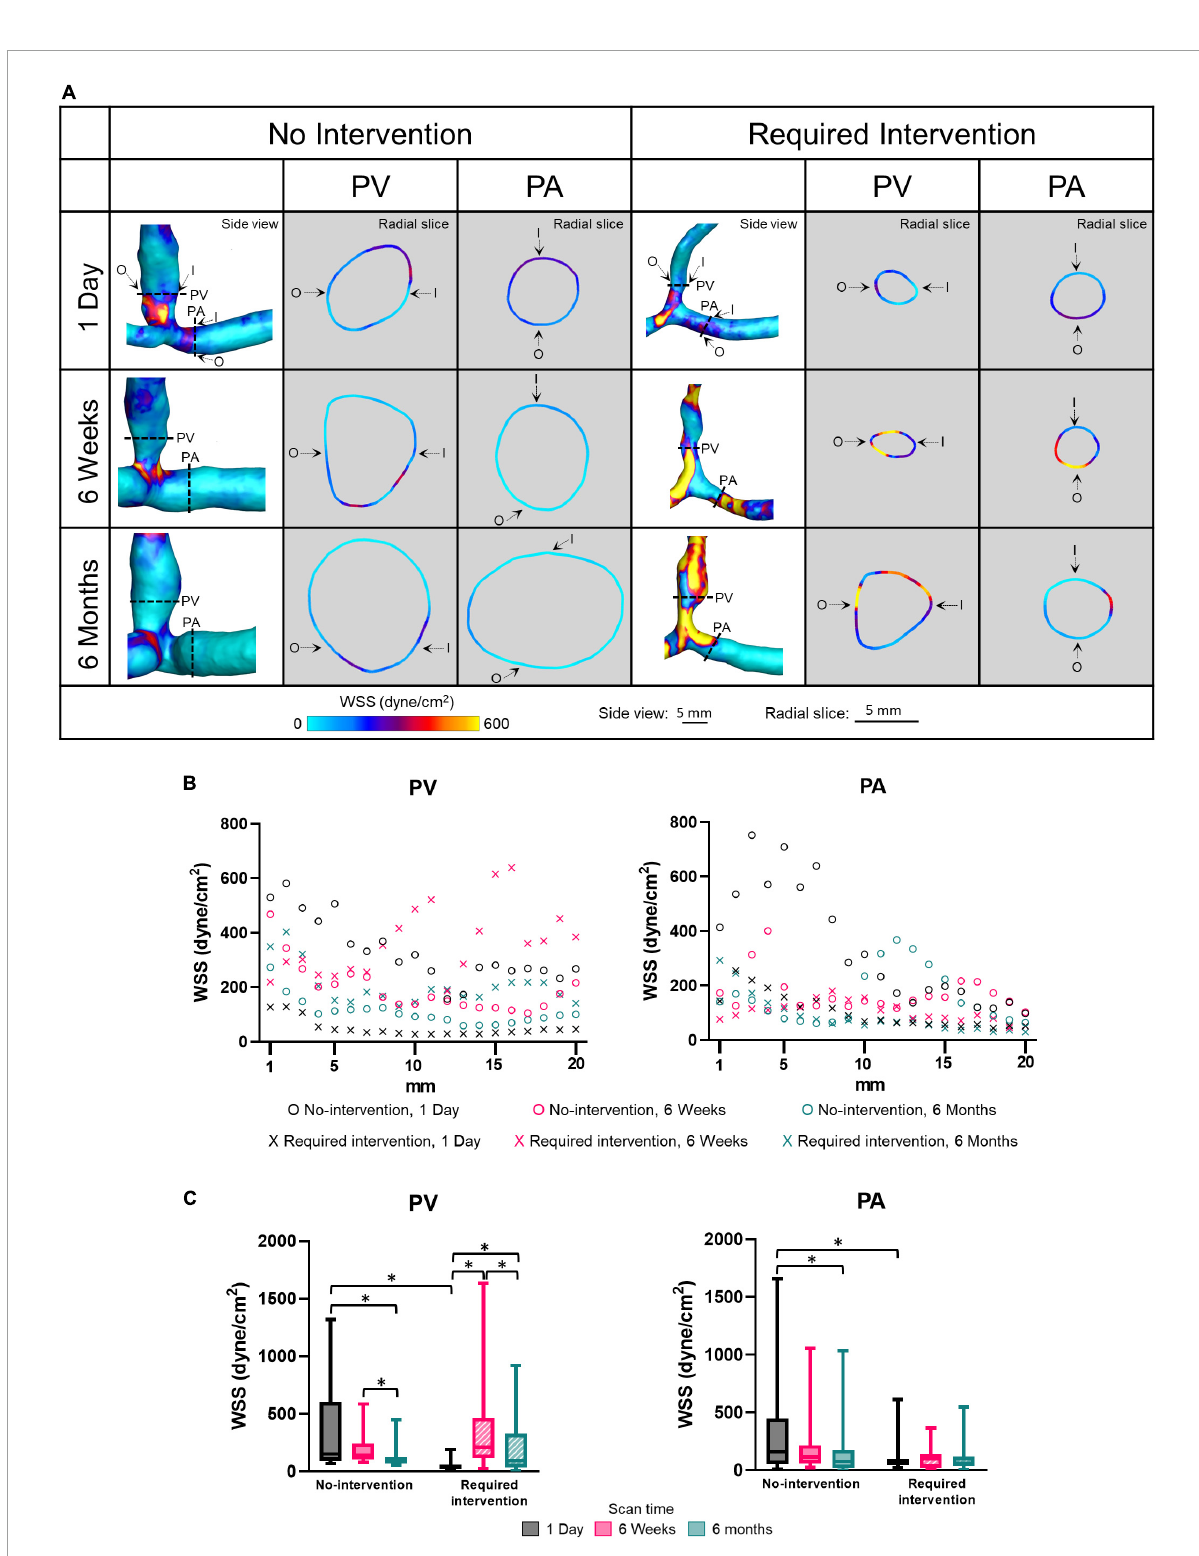
FIGURE4 Wall shear stress (WSS) of the proximal vein (PV) and proximal artery (PA). (A) The side view and radial slices of WSS color maps of representative arteriovenous fistulas at systole. Dotted lines in the side view color maps show the location of radial slices, approximately 5 mm from the anastomosis. O and I denote the locations of outer and inner walls, respectively. (B,C) Show WSS for the "no intervention" and "required intervention" groups at 1 day, 6 weeks, and 6 months, as explained in Figure 2 . ∗ P <